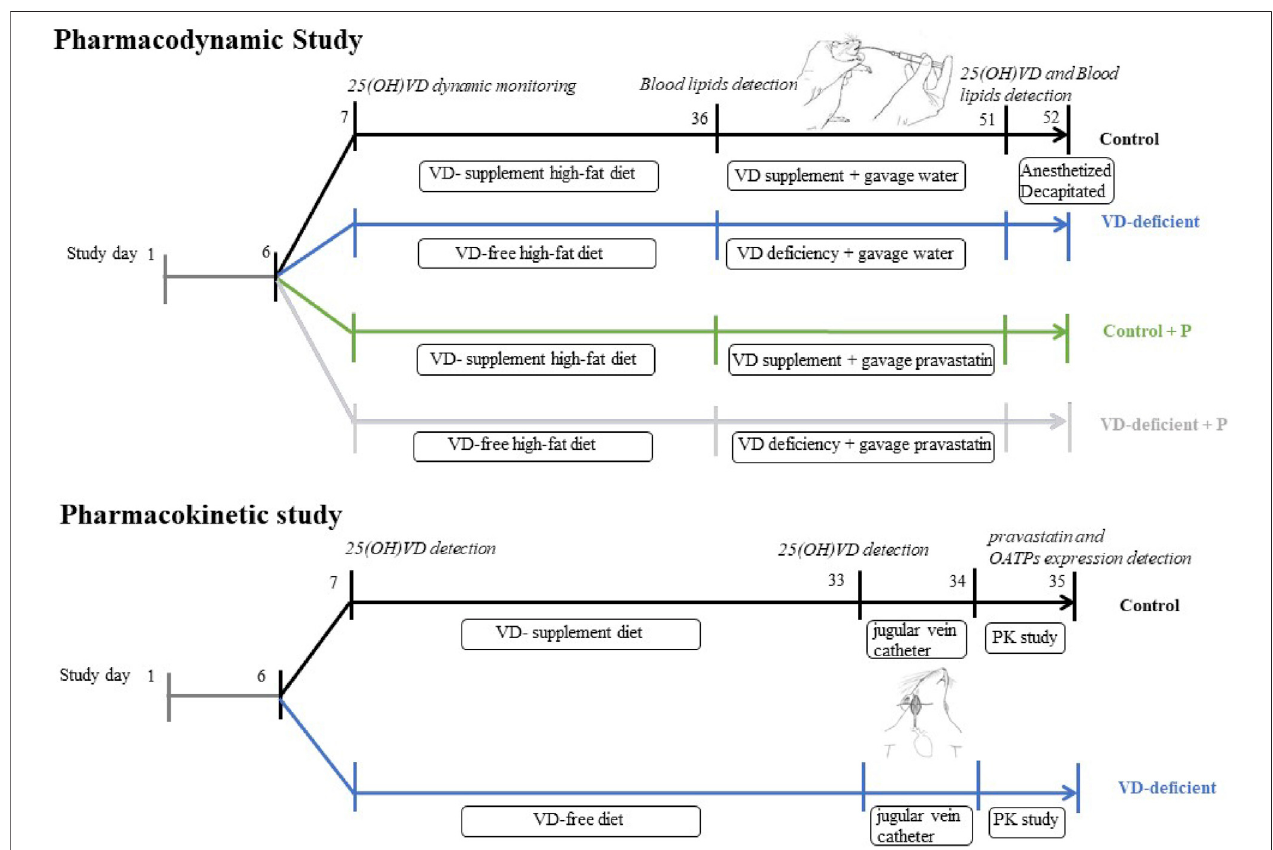
FIGURE1| Studydesignofpharmacodynamic andpharmacokineticexperimentsinrats.Pharmacodynamicstudy:pharmacodynamicstudyofpravastatininVD- suf fi cient (Control, Control + P) or VD-de fi cient (VD-de fi cient, VD-de fi cient + P) rats. Pharmacokinetic study: pharmacokinetic study of pravastatin in VD-suf fi cient (Control)orVD-de fi cientrats.Control:ratsfedonaVD-supplementdietwithorwithoutgavageofwater;VD-de fi cient:ratsfedonaVD-freedietwithorwithoutgavageof water; Control + P: rats fed on a VD-supplement diet and administered pravastatin via gavage for 15 days; VD-de fi cient + P: rats fed on a VD-free diet and administered pravastatin via gavage for 15 days.